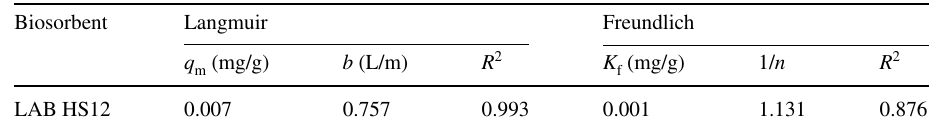
Table 1 The Langmuir and Freundlich parameters for the As biosorption of HS12 LAB